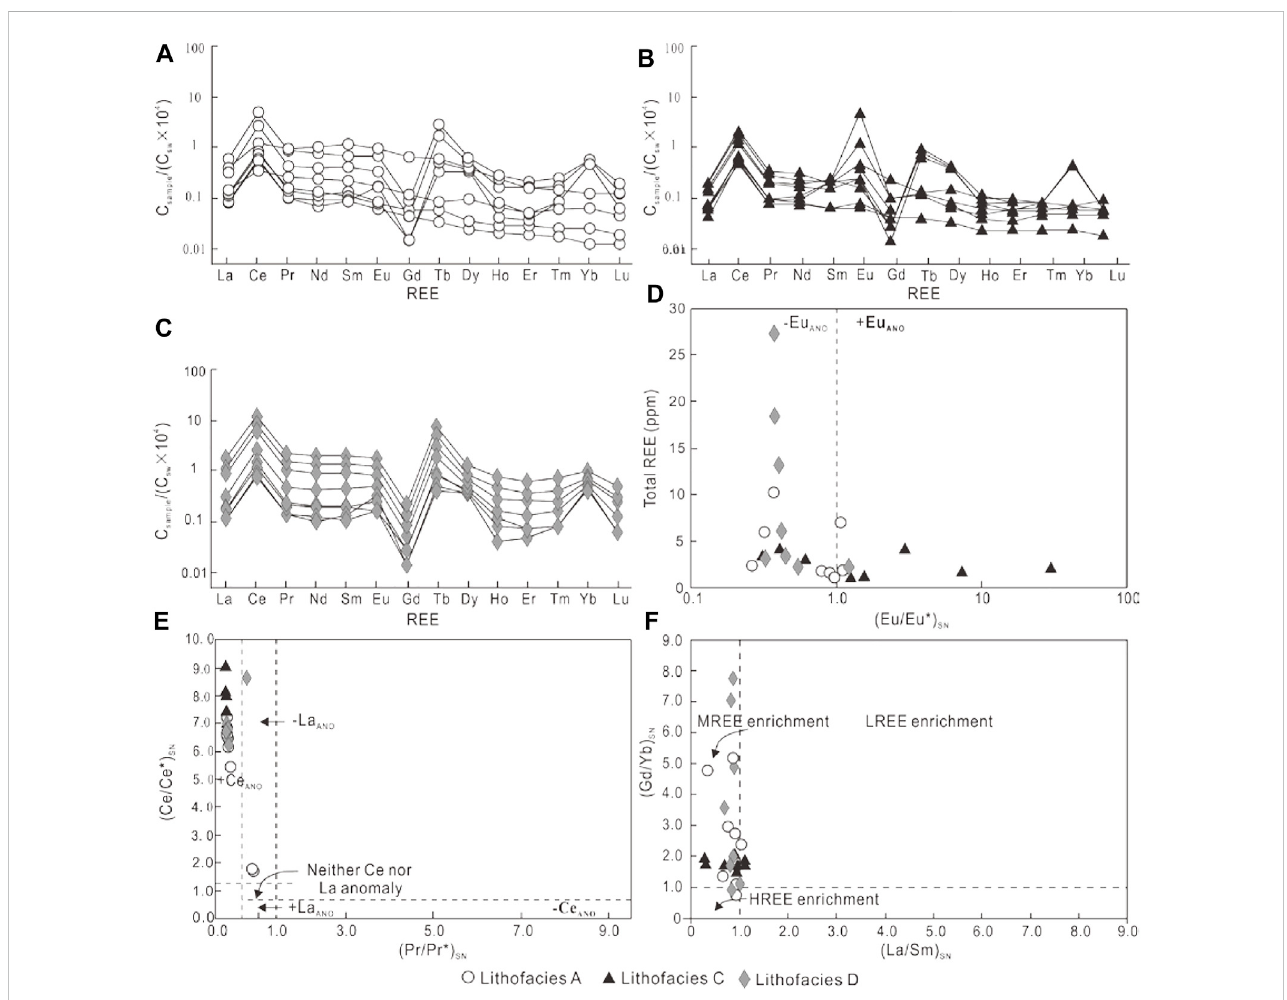
FIGURE 9 Seawater-normalized REE patterns and binary diagram of different lithofacies in Feixianguan Formation tight oolitic reservoir.